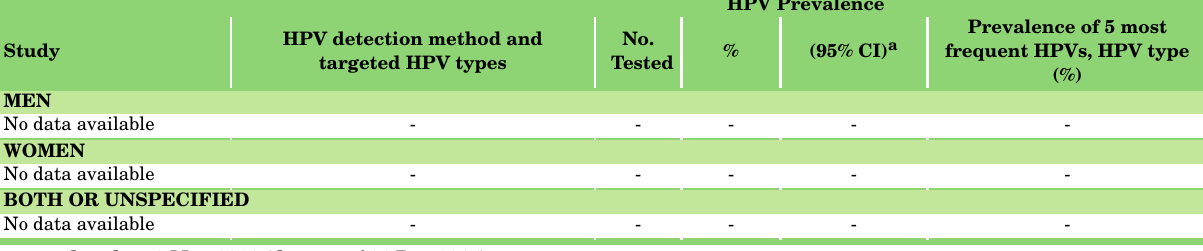
Table 38: Studies on HPV prevalence among cases of hypopharyngeal or laryngeal cancer in